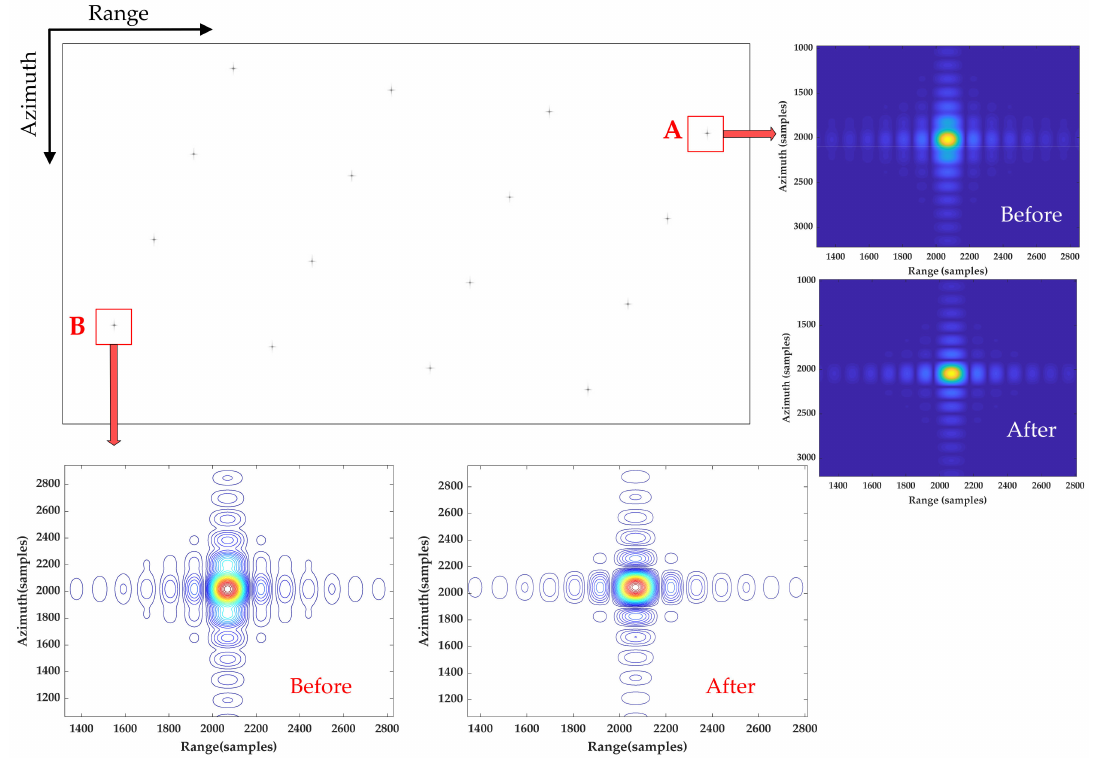
Figure 14. Imaging results before and after the precise focusing by hybrid correlation with kernel gate function.